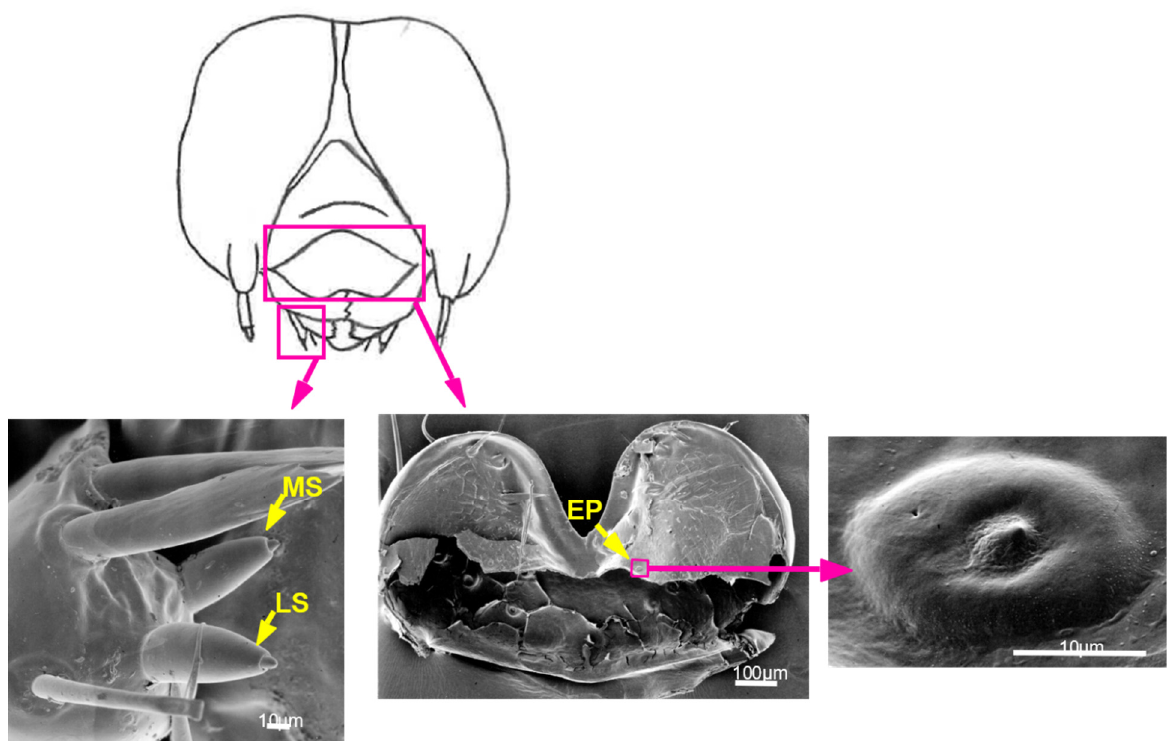
Figure 6. Scanning electron micrographs of contact chemosensilla on the mouthparts of the larvae of Atrophaneura alcinous. LS: lateral styloconic sensilla; MS: medial styloconic sensilla; EP: epipharyngeal sensilla.